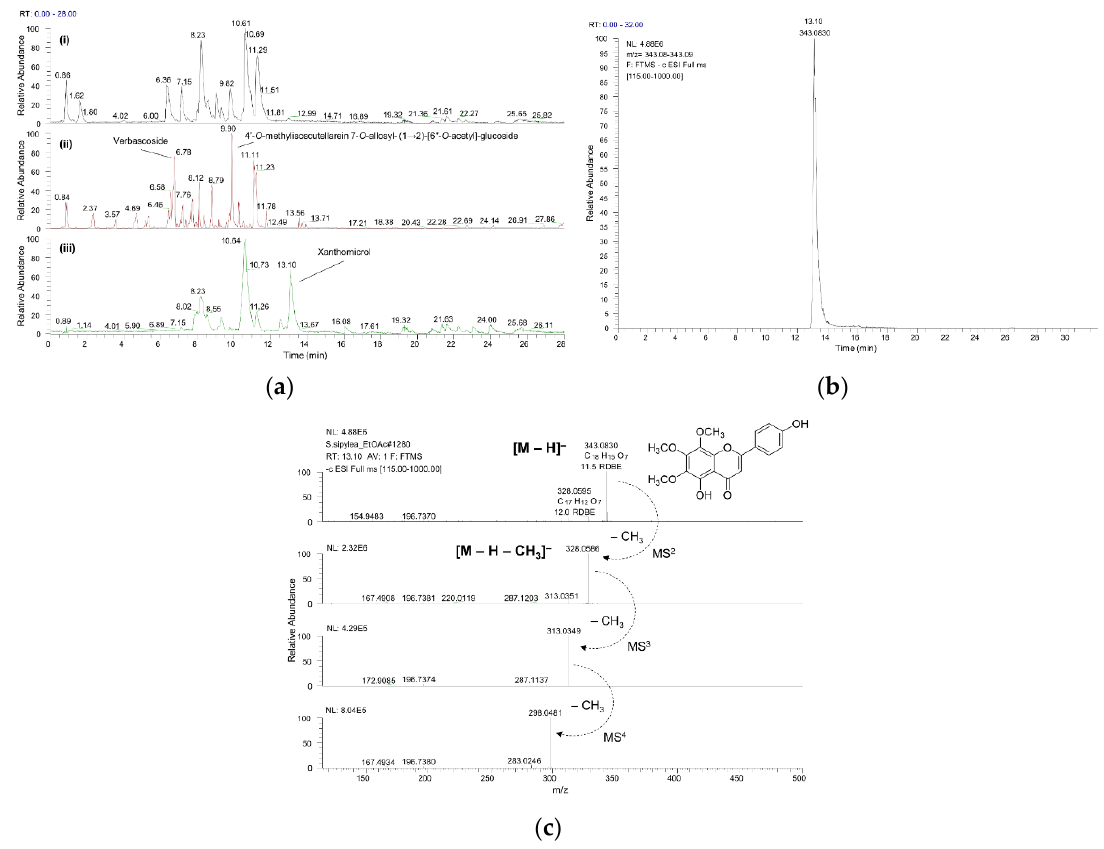
Figure 2. ( a ) UPLC-ESI(–)-HRMS chromatograms of (i) water/methanol (HA), (ii) methanol (ME), and (iii) ethyl acetate (EtOAc) total extracts of S. sipylea . ( b ) Extracted ion chromatogram (XIC) of xanthomicrol, detected mainly in the EtOAc extract. ( c ) High-resolution mass spectrometry (HRMS) spectra indicating the fragmentation pattern of xanthomicrol; full scan (top trace) and HRMS 2 to HRMS 4 spectra.